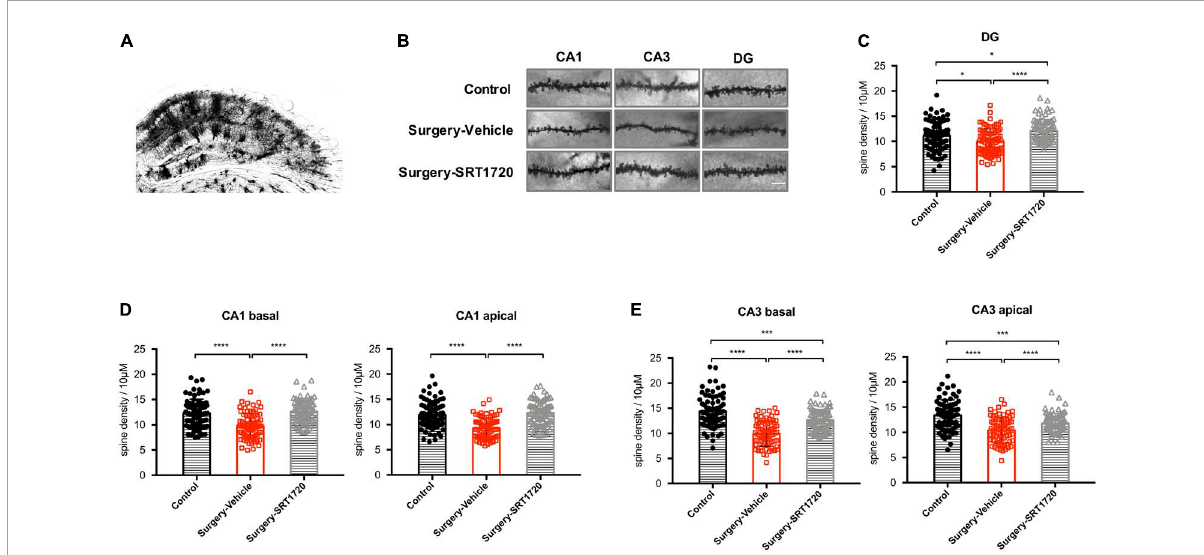
FIGURE6 SIRT1 activation restores surgery-induced spine loss. (A) Representative images of Golgi staining of hippocampus. (B) High-magnification representative images of dendritic spine from each experimental group. Scale bar, 5 µ m. (C) Spine density of dentate gyrus (DG) neurons. n = 80–84 spines from four mice per group. (D) Spine density in apical and basal dendrites of CA1 neurons, n = 78–80 spines from four mice per group. (E) Spine density in apical and basal dendrites of CA3 neurons. n = 74–80 spines from four mice per group. One-way analysis of variance (ANOVA) with Tukey post hoc test. All data are shown as mean ± SD. * p < 0.05; *** p < 0.001; **** p < 0.0001.